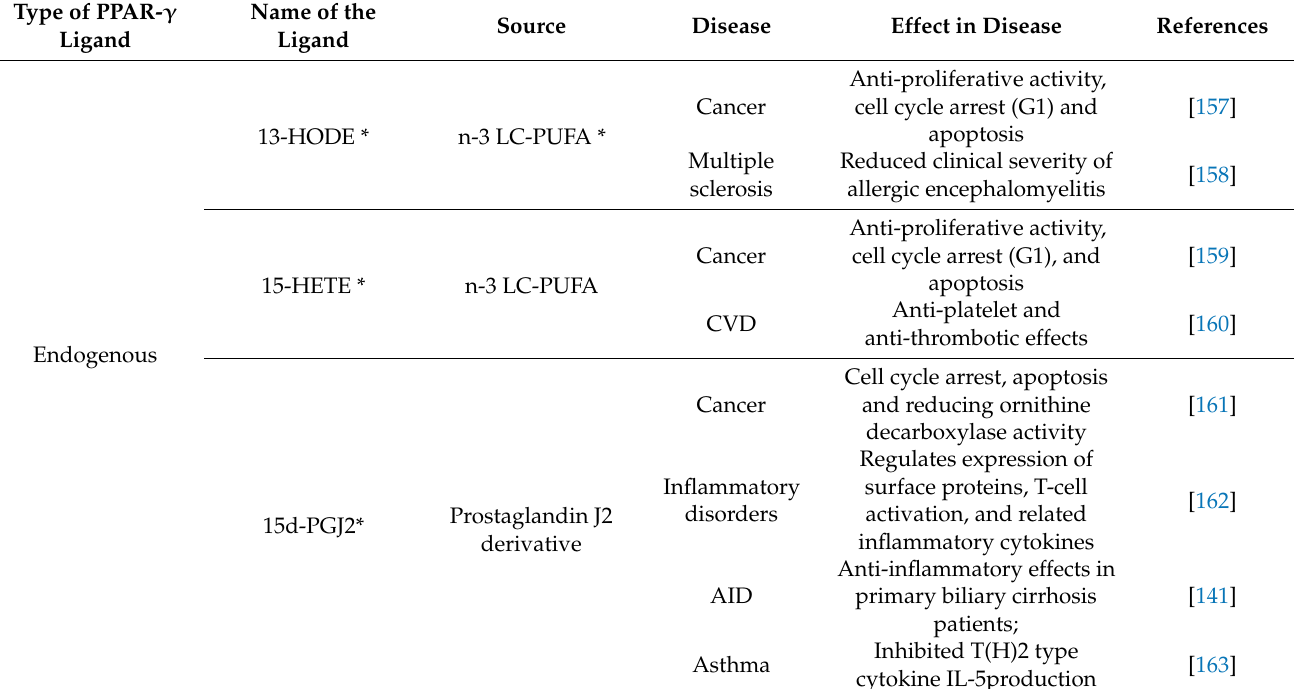
Table 2. List of ligands activating PPAR- γ and their significant role in various